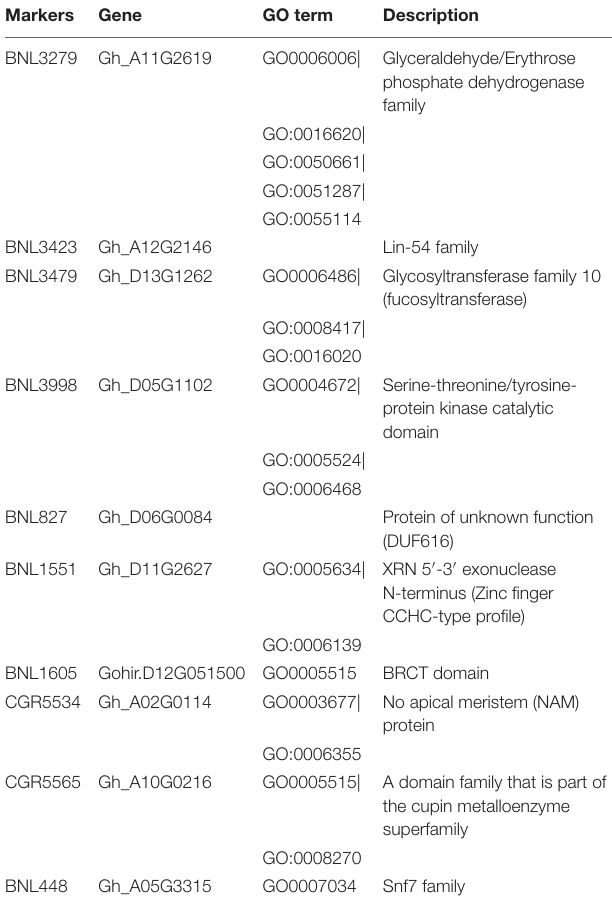
TABLE 5 | List of annotated markers associated with candidate genes and their possible function. Markers